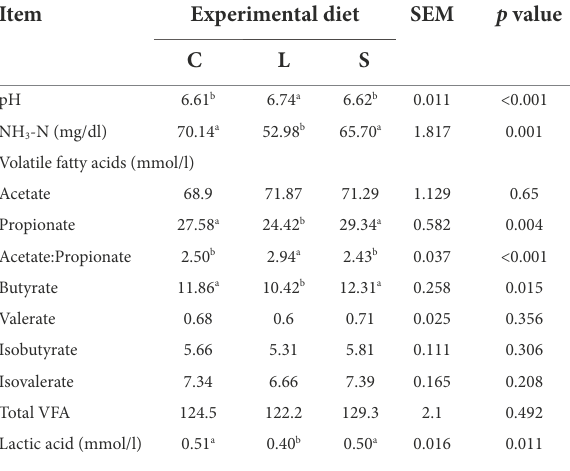
TABLE 3 Effect of two glucogenic (C, S) and a lipogenic (L) diet on the ruminal pH and end-products after 48 h in vitro fermentation with rumen fluid.